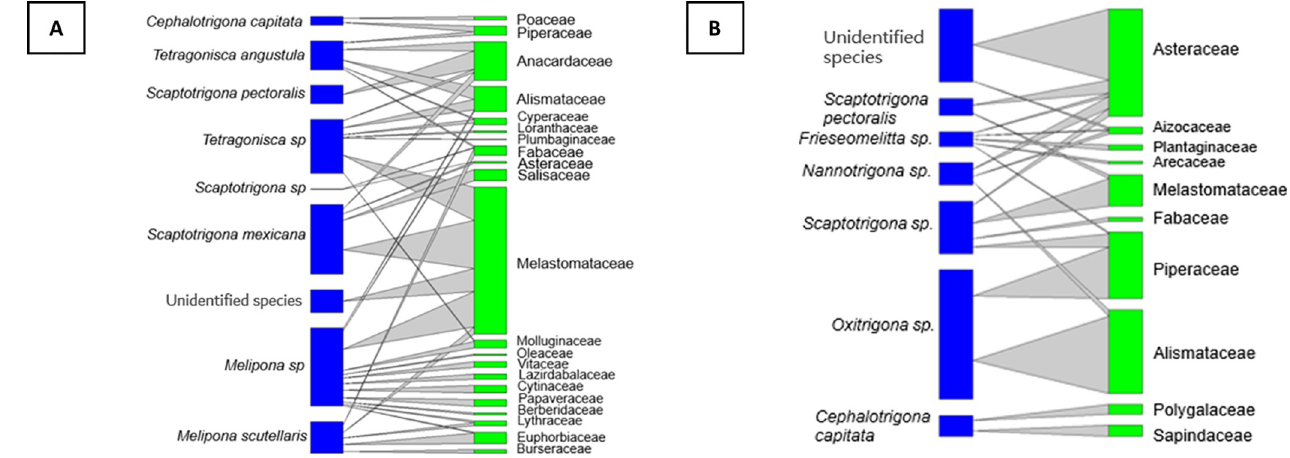
Fig 5. Bee-plant interaction network. A) Amazon region. B) Sierra South